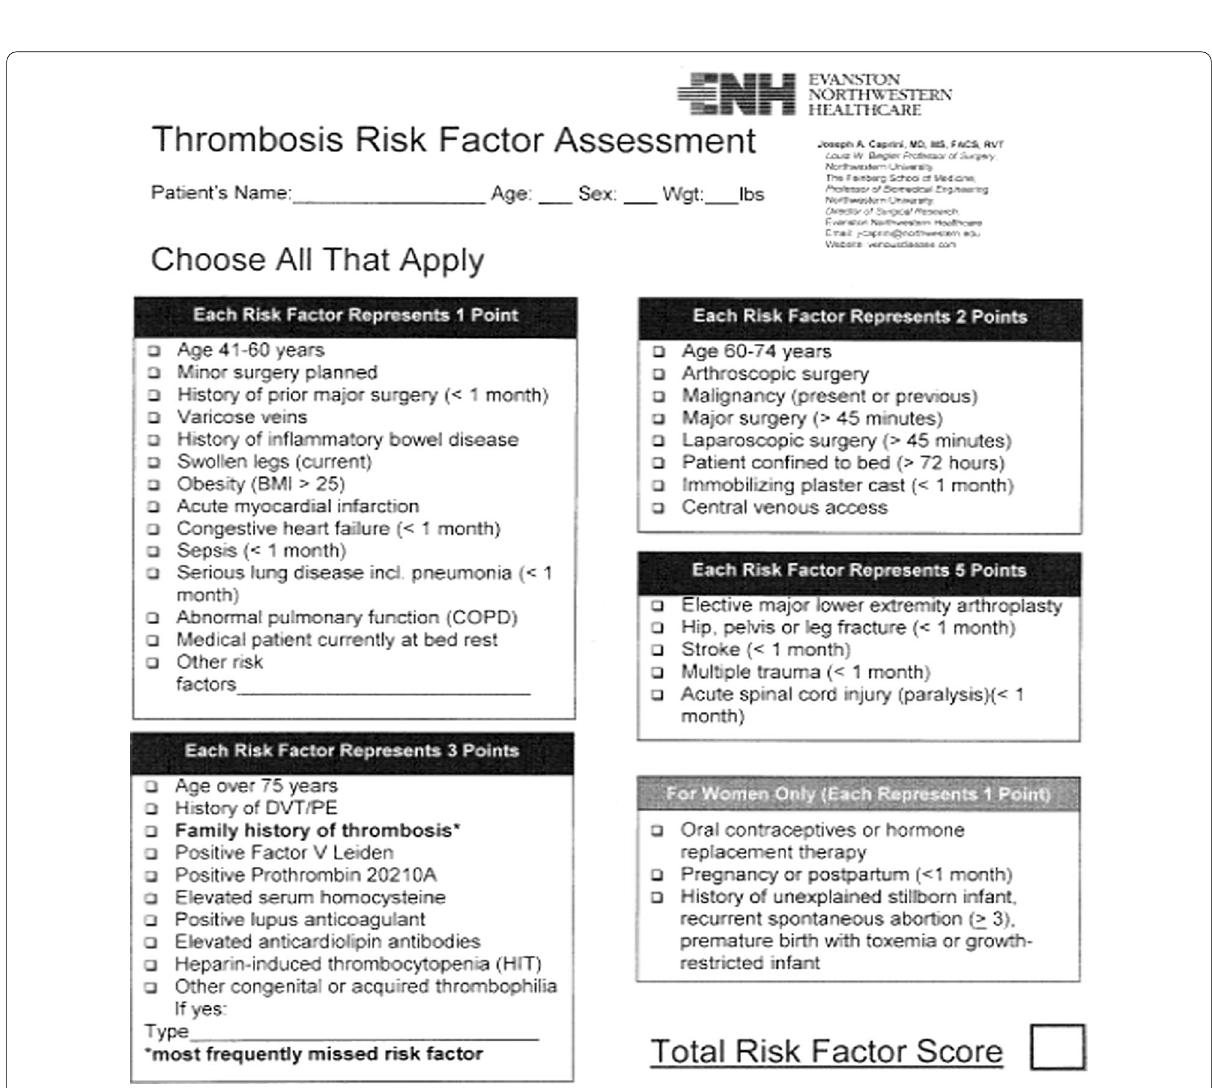
Fig. 1 2005 Caprini risk assessment model [5]